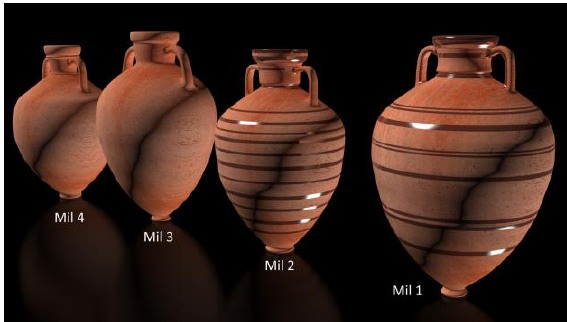
Figure 11. Milesian amphoras from 7 th -5 th century BC.